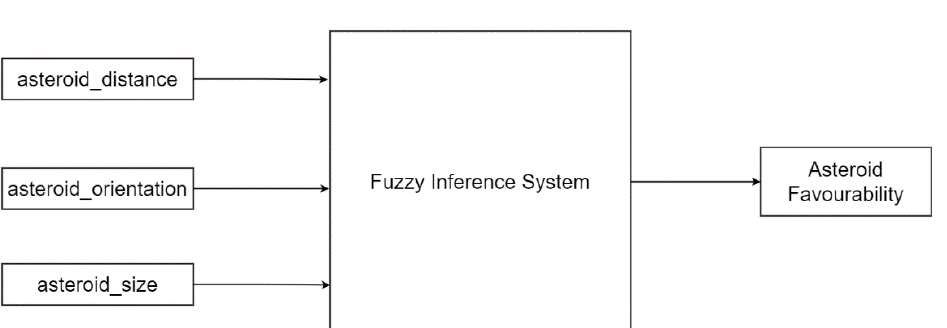
Figure 4. XAI Core block diagram.